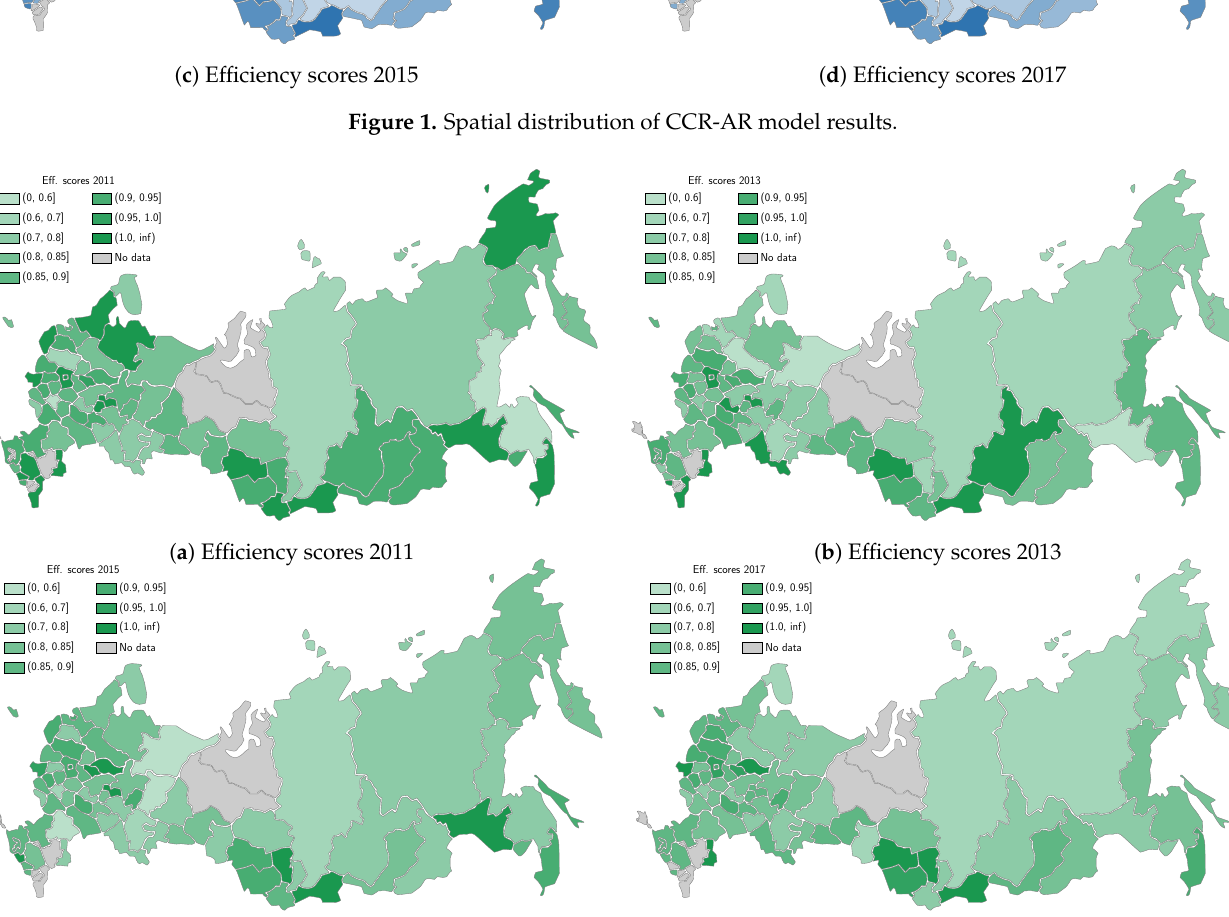
Figure 2. Spatial distribution of SBM model